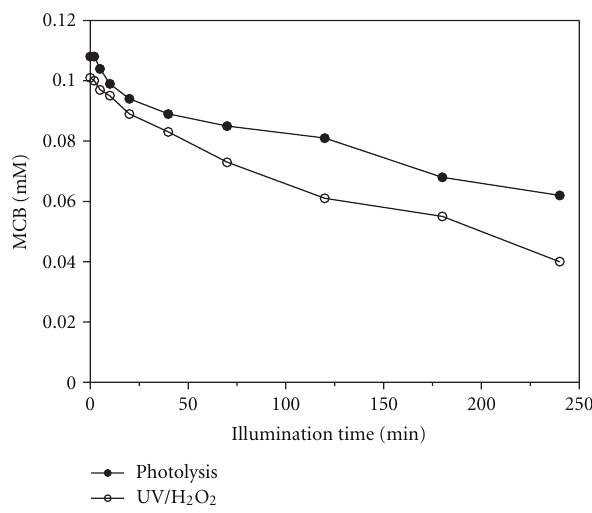
Figure 1: Direct photolysis and H 2 O 2 -assisted photolysis of MCB.